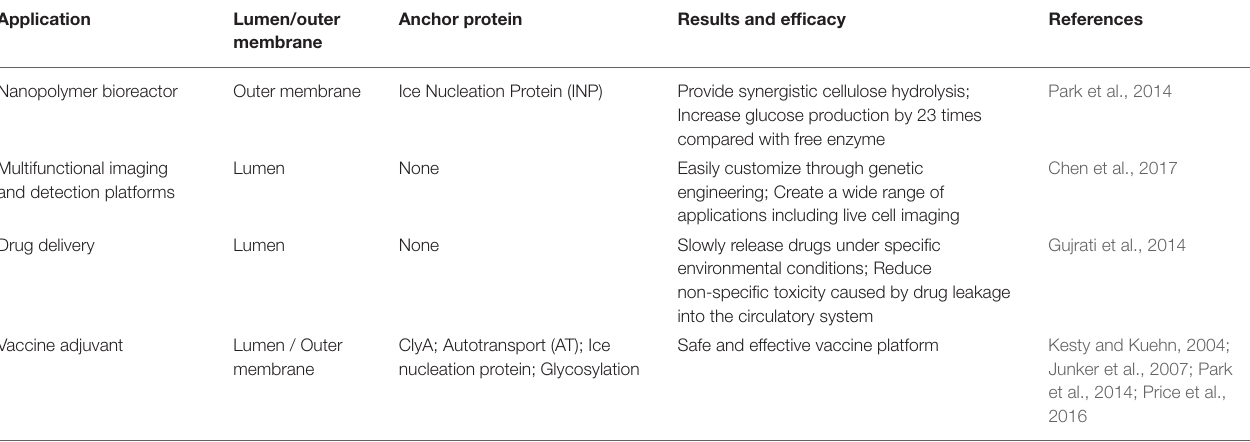
TABLE 2 | Application and performance of engineered OMVs.